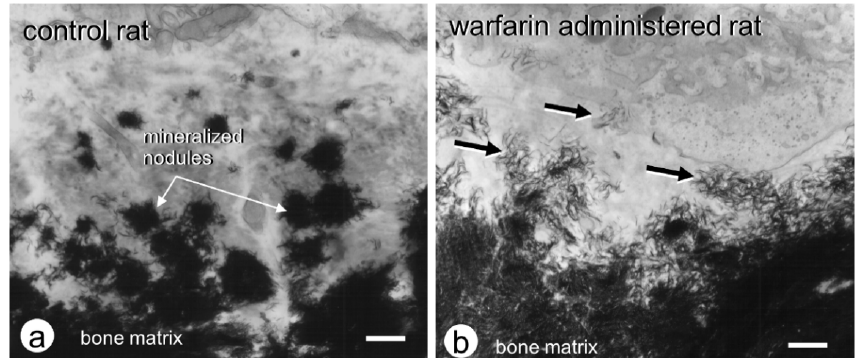
Figure 3. TEM observation on normal mineralized nodules and dispersed mineral crystals in osteoid. ( a ) Normal rats demonstrate globular assembly of mineral crystals in osteoid. ( b ) When administered with warfarin, an inhibitor of g-carboxylation, however, many dispersed mineral crystals (arrows) are seen in the osteoid. The images are cited from Ref. [71]. Reprinted with permission from Ref. [71]. 2009, Oxford University Press. Bar, 2